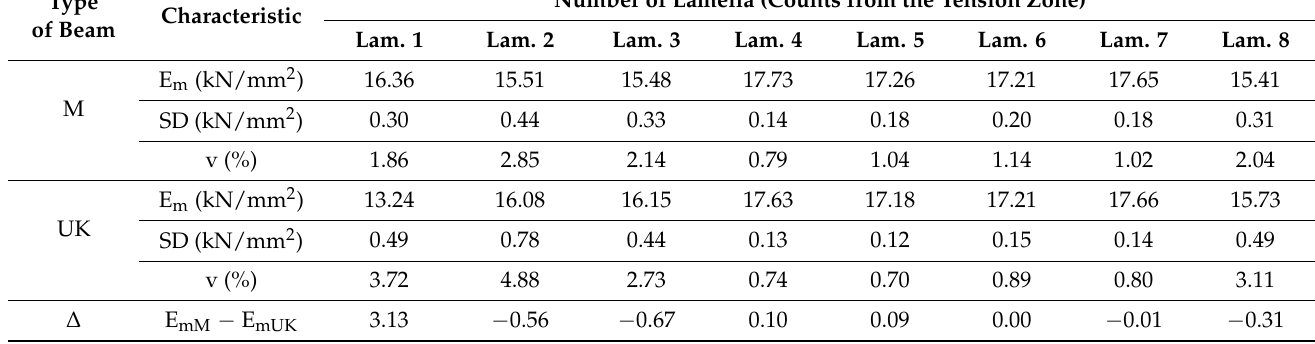
Table 1. Quality of lumber used in the research and determined by the measurement of the modulus of